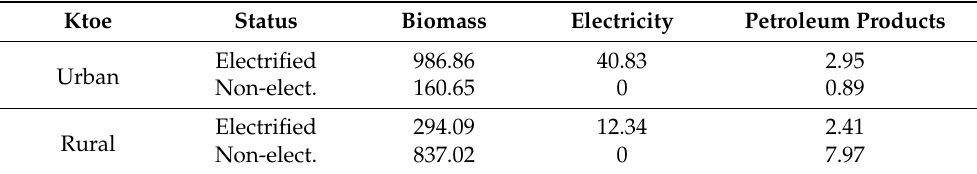
Table 1. Assumed values representative for Mali. Ktoe Status Biomass Electricity Petroleum Products